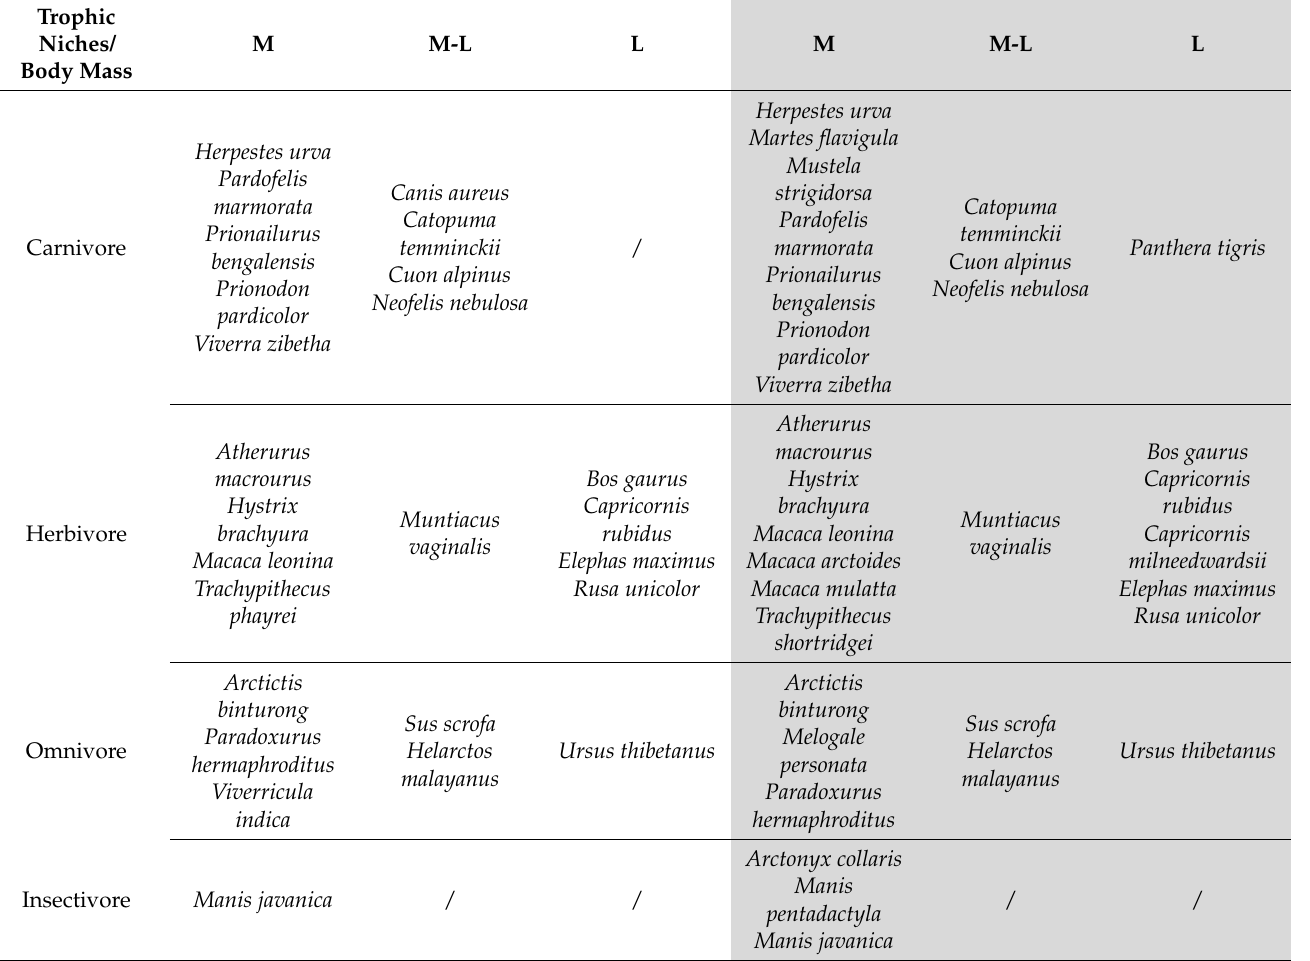
Table 3. Number of observed species for each trophic niche group (carnivore, herbivore, omnivore, and insectivore) in each body mass group (M: medium; M-L: medium-large; L: large) in both areas (left in white: Rakhine Yoma Elephant Range (RYER); right in grey: Htamanthi Wildlife Sanctuary